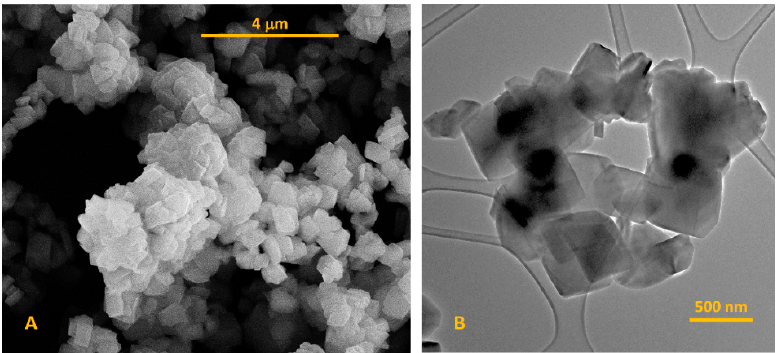
Figure 2. SEM ( A ) and TEM ( B ) micrographs of NaY zeolite.